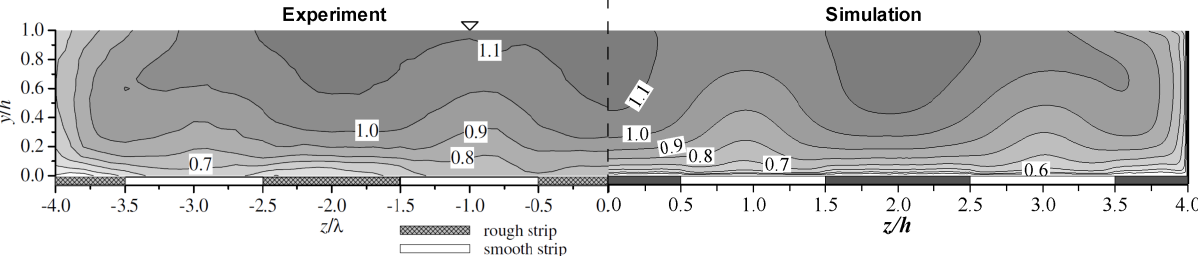
Figure 5. Contours of time-averaged streamwise velocity, normalized on the bulk velocity, for experiments (( left ) half of the cross section) and LES ( right ). The contours provided by the simulation were averaged in the streamwise